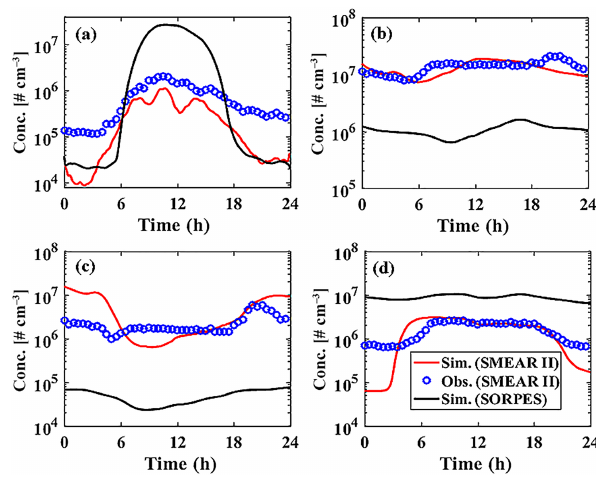
Figure 2. Averaged simulated and measured diurnal cycles of (a) H 2 SO 4 , (b) HOM non-nitrate monomers, (c) HOM dimers, and (d) HOM organonitrates at SMEAR II and SORPES.